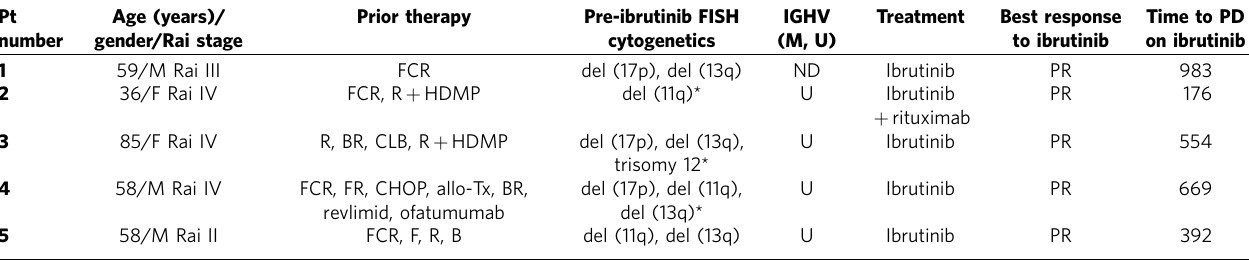
Table 1 | Patient